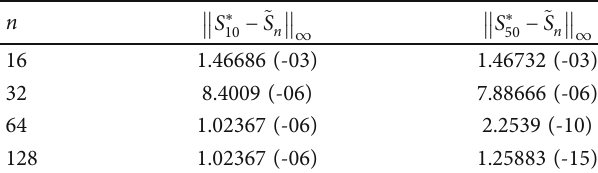
~ and and S ∗ S n 10